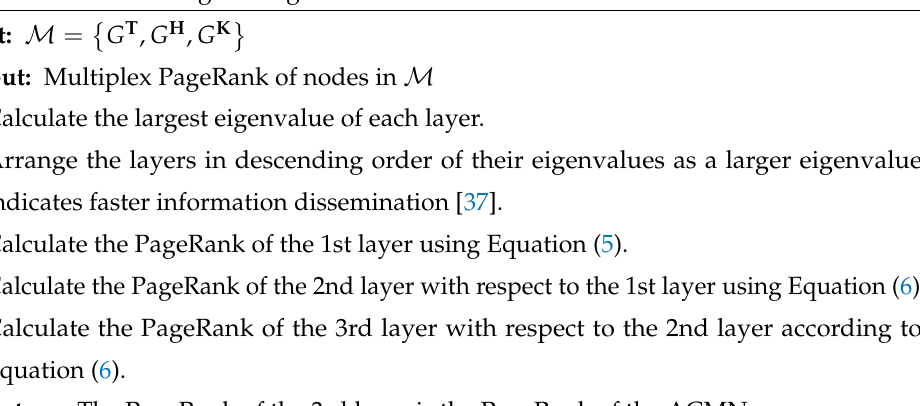
Algorithm 1 Calculating the PageRank of nodes in the